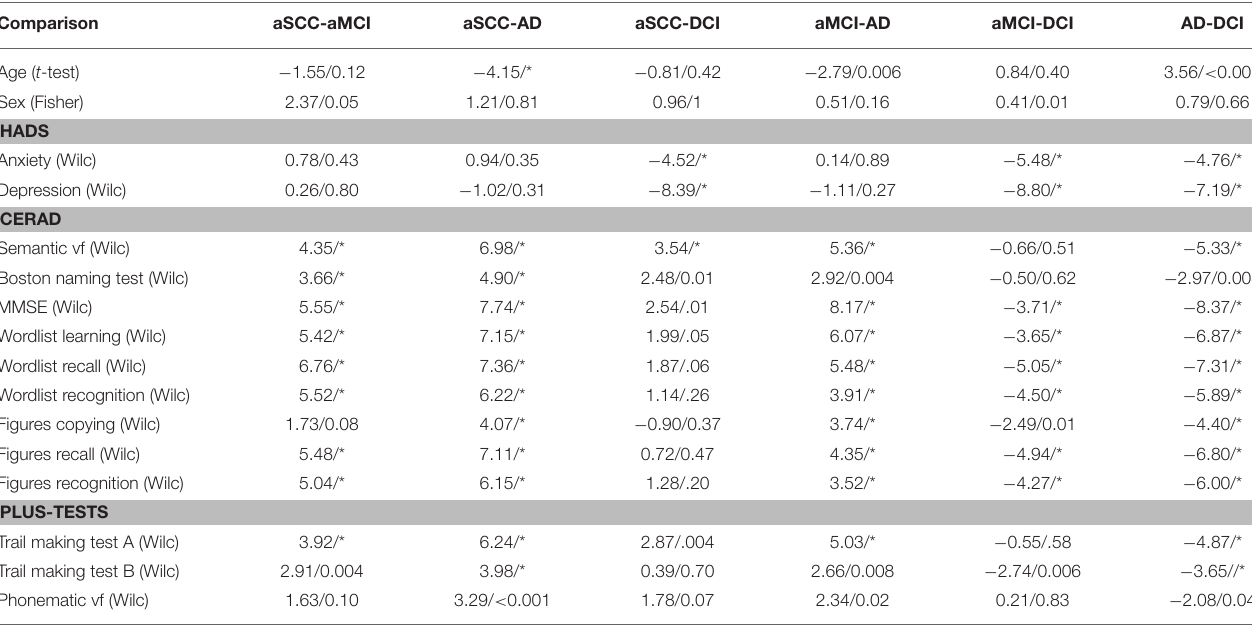
TABLE 2 | Sample comparisons test-value/ p